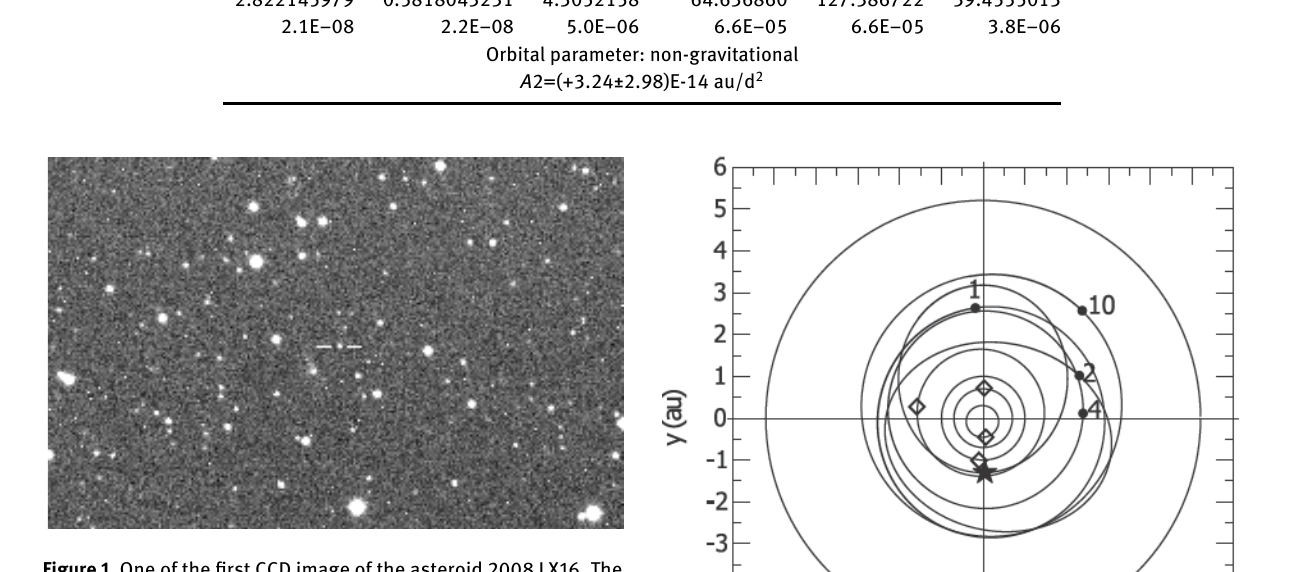
Figure 1. One of the first CCD image of the asteroid 2008 LX16. The size of field is 7 arcmin x 10 arcmin. The image (480 s exposure) taken at the Baldone Astrophysical Observatory with the Schmidt telescope on the night April 19 of 2018.